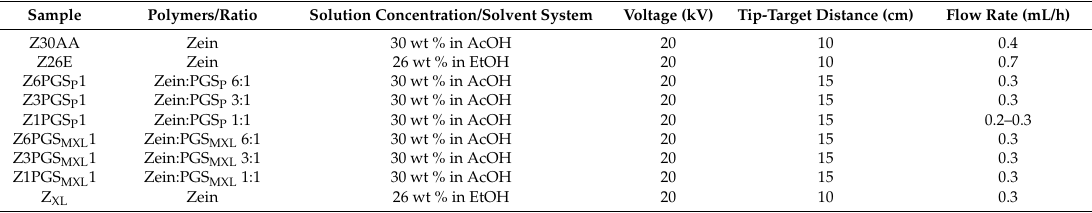
Table 1. Compositions of polymer solutions and electrospinning parameters of all fiber mats fabricated in this